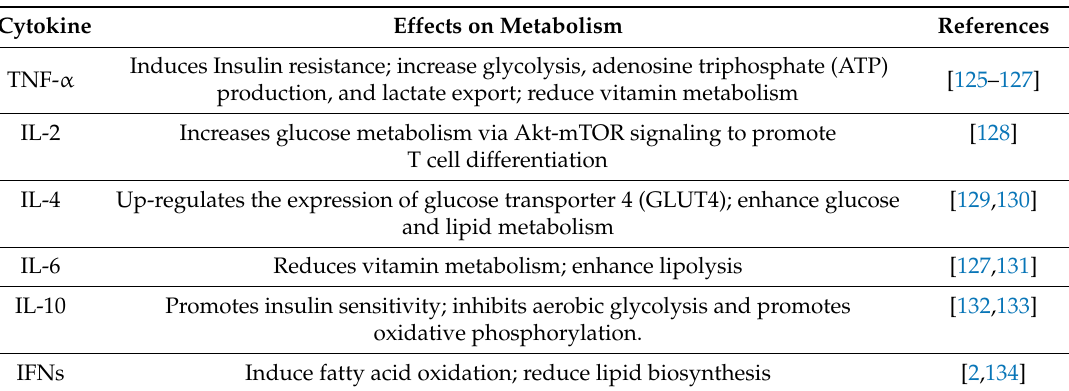
Table 1. Role of important cytokines in